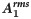
β-Power and the root mean square value of the activity A1rms as functions of the coefficient of variation vf, in the case of the reduced model.The β-Power and the A1rms were computed from the synaptic current I1 corresponding to the neural population N1, for non-periodic stimulation patterns configured with H0DBS=10 and δ = 0.5 ms applied to the population N2. The β-Power has been normalized with respect to that obtained for the system in the oscillatory state without stimulation (H0DBS=0). The non-periodic stimulation patterns were generated using random instantaneous frequencies with a mean value of 〈fDBS〉 ∼ 130 Hz. Each point in the graph corresponds to the mean value and the standard deviation of 10 realizations for each vf value (see section “Materials and methods”).